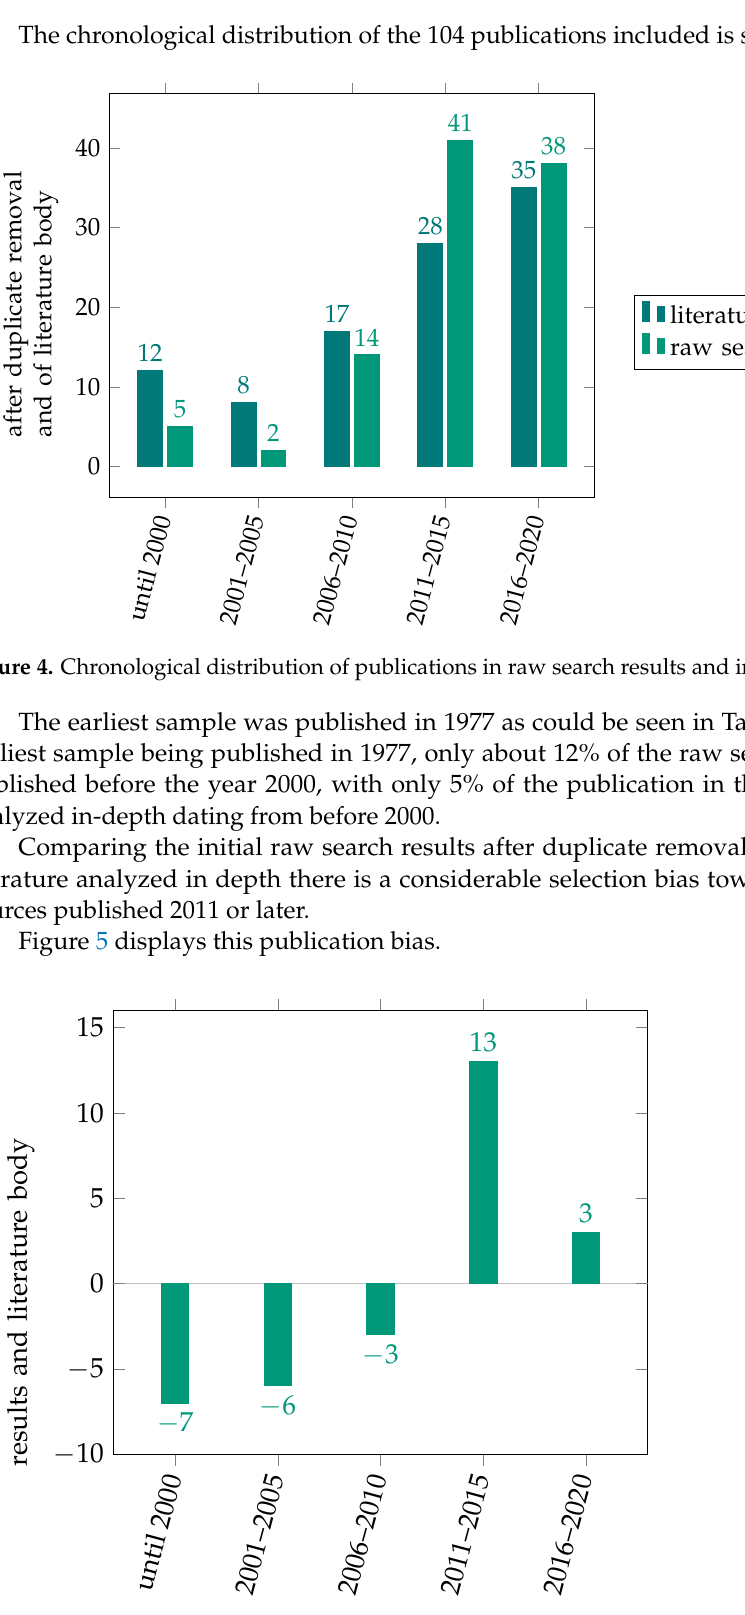
Figure 5. Comparison of actually included and raw search result